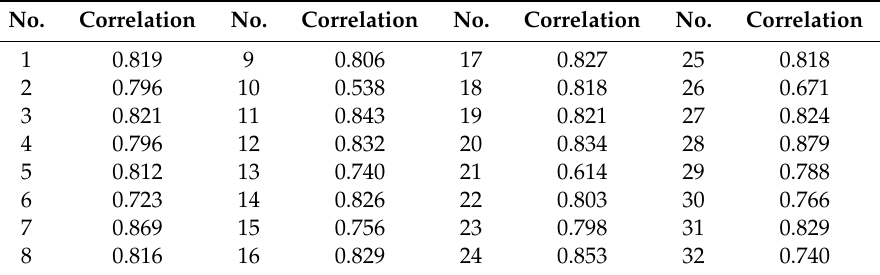
Table 1. Results of the correlation coe ffi cients of the evaluators.